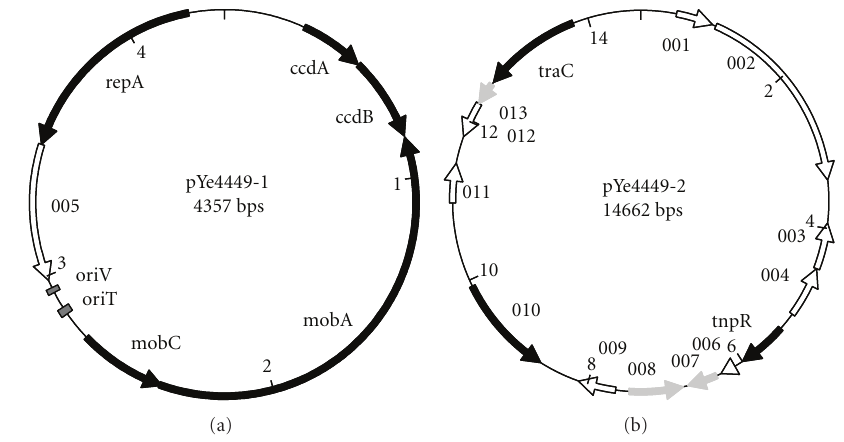
Figure 2: Maps of plasmids pYe4449-1 and pYe4449-2 . Open reading frames (ORFs) with attributable functions and e-values below e-20 are indicated by black arrows, ORFs with significant homology to database entries (e-values below e-10) but unclear functions are indicated by grey arrows, and ORFs without significant homology (e-values above 0.1) to database entries are indicated by white arrows. Details about identified ORFs are given in Tables 1 and